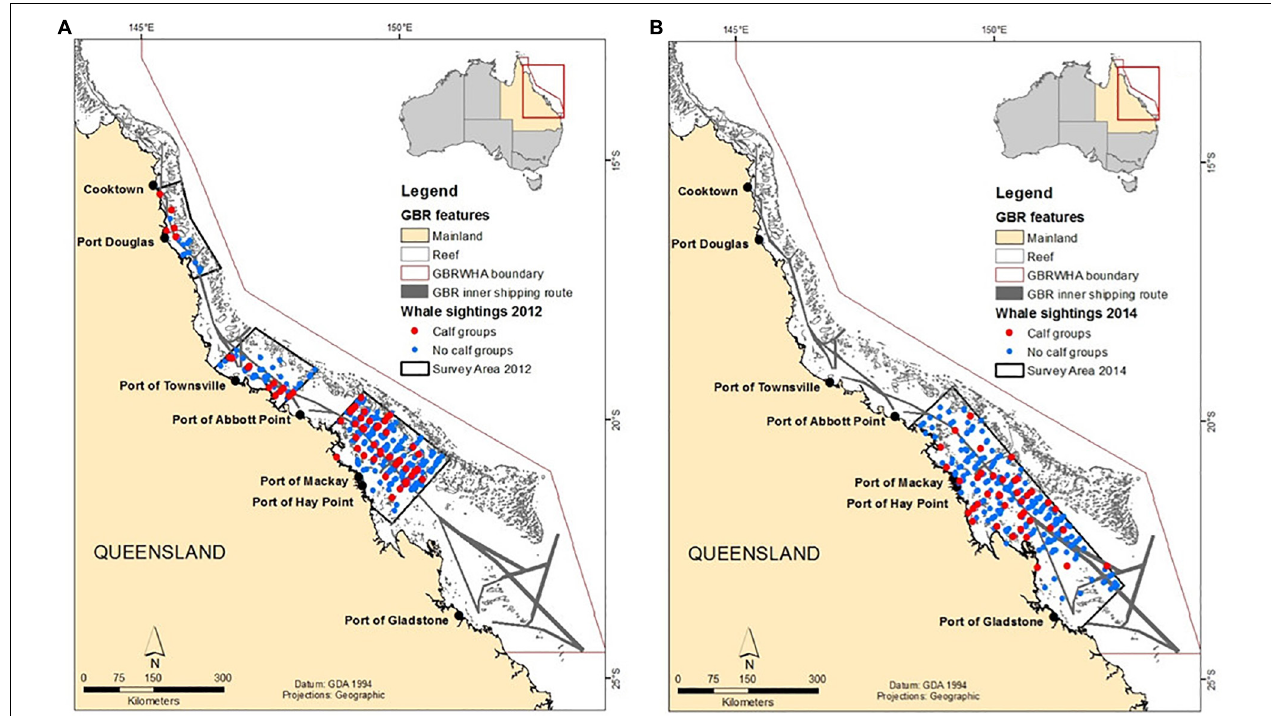
FIGURE 2 | Distribution of humpback whale sightings of calf and non-calf groups during the (A) 2012 and (B) 2014 aerial surveys.